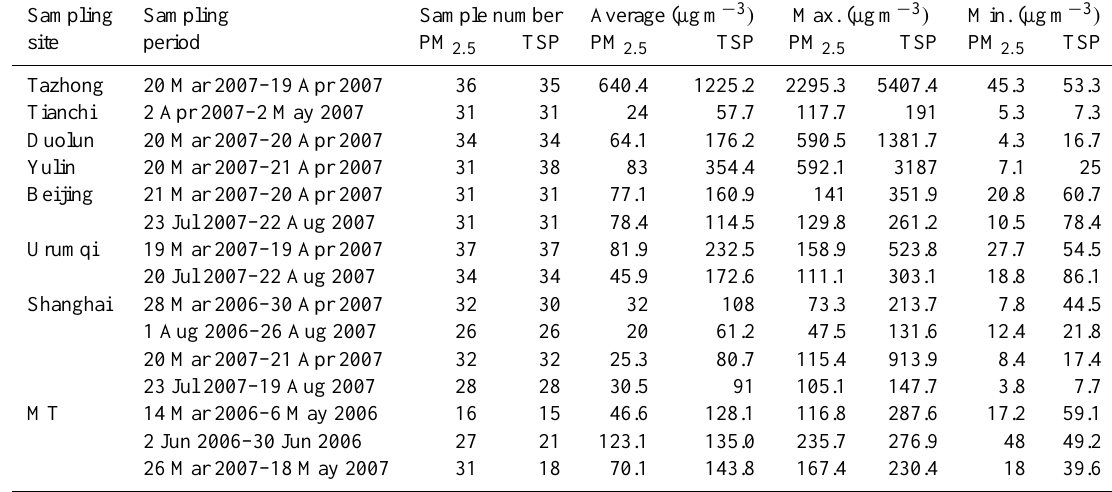
Table 1. Mass concentrations of aerosols (µgm − 3 ) at the summit of MT and other sampling sites.